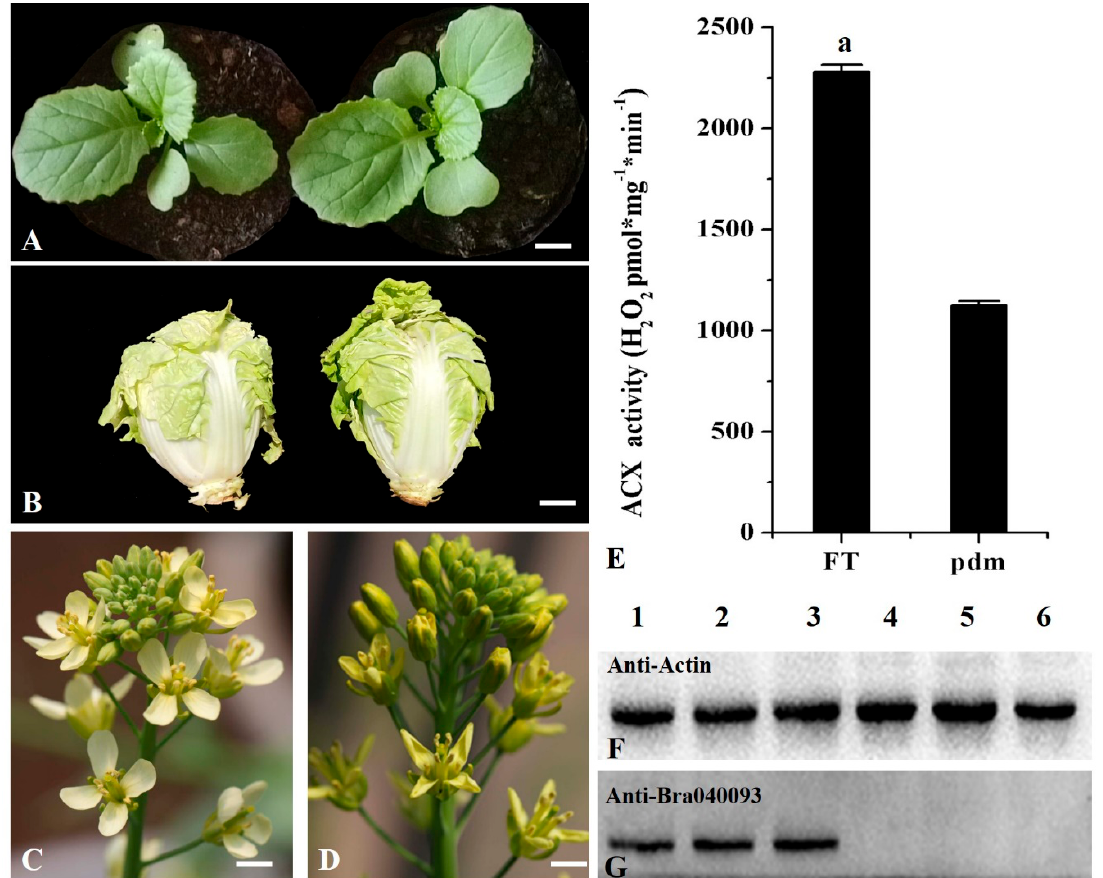
Figure 1. Phenotypes of ‘FT’ and pdm plants and analysis of Bra040093 expression patterns. ( A – D ) Phenotypes of ‘FT’ and pdm plants. (( A ) at the seedling stage, ( B) at the heading stage, and ( C , D ) at the flowering stage. Left: ‘FT’; Right: pdm .); ( E ) The activity of ACX in the petals of ‘FT’ and pdm plants. ( F , G ) Western blot analysis of Bra040093-encoded protein expression. (Lanes 1–3: Petals of ‘FT’; lanes 4–6: Petals of pdm .).